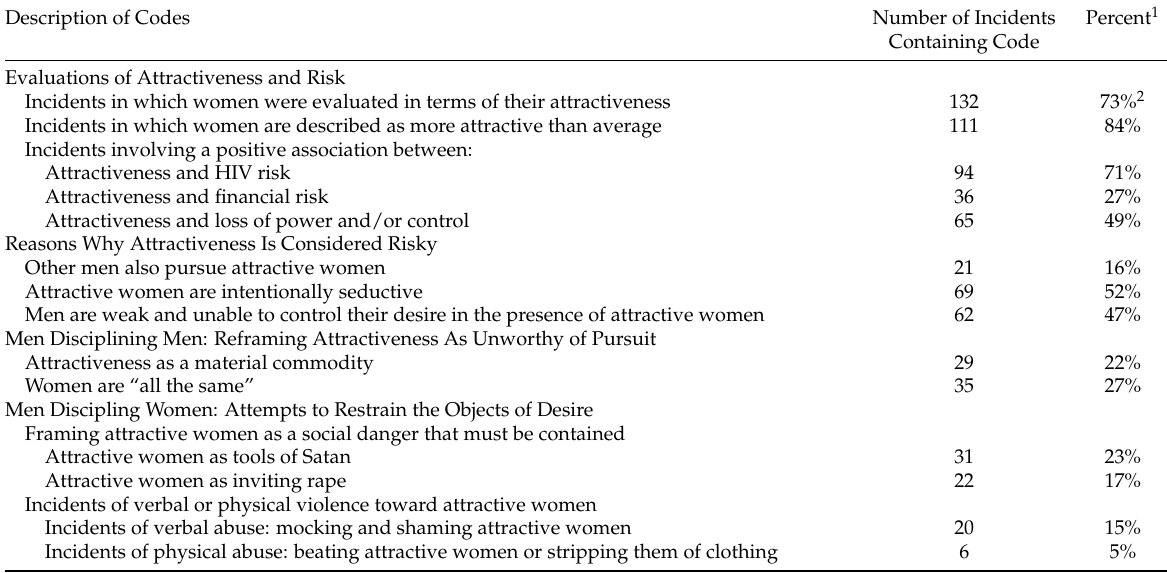
Table 2: Prevalence of major themes discussed in the article. Description of